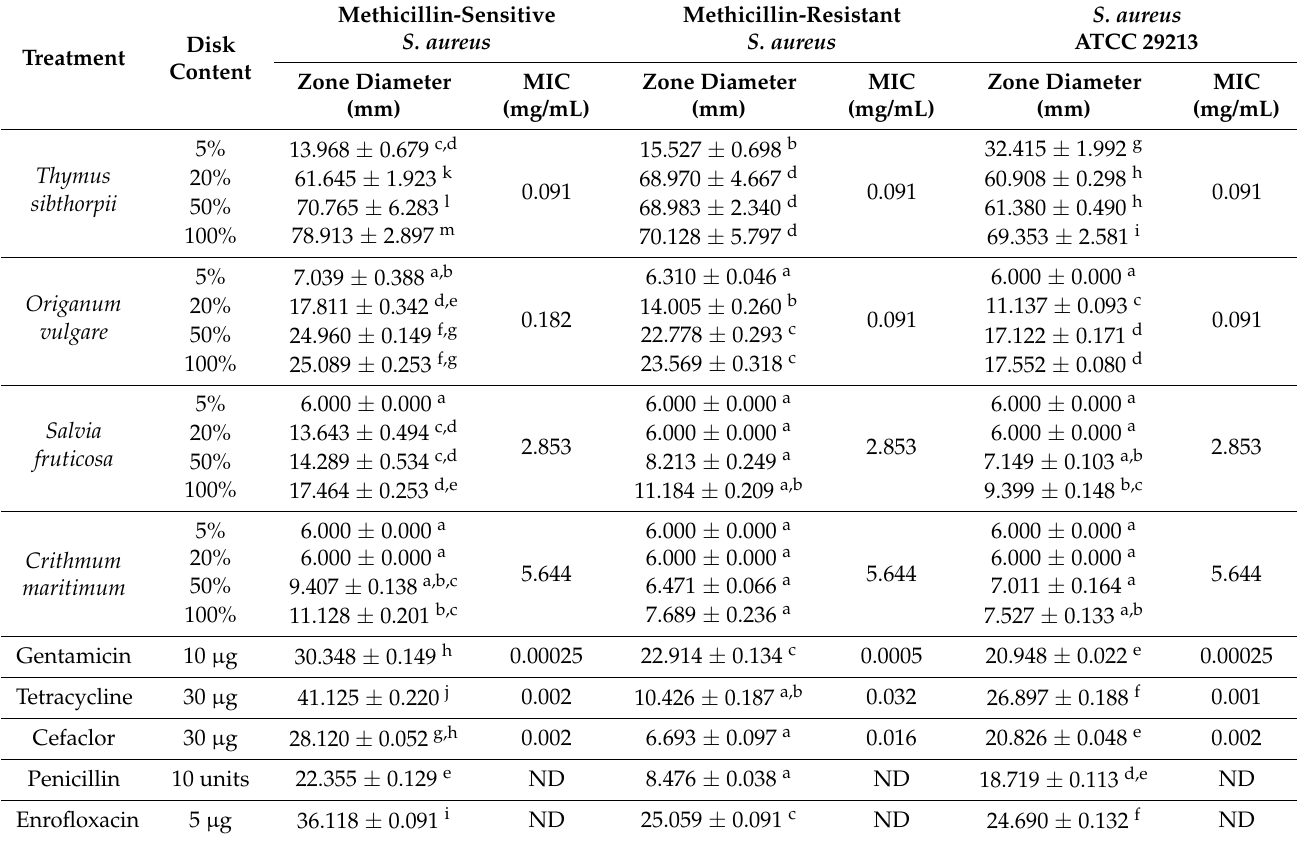
Table 2. Inhibition zone diameter and minimum inhibition concentration of essential oils and reference antibiotics on treating microorganisms. A 6 mm inhibition zone diameter indicates no activity, and ND means not determined. Each value represents the mean of triplicate experiments with standard deviations. Different superscripts (a–m) in the row differ significantly for each strain (Tukey, p ≤